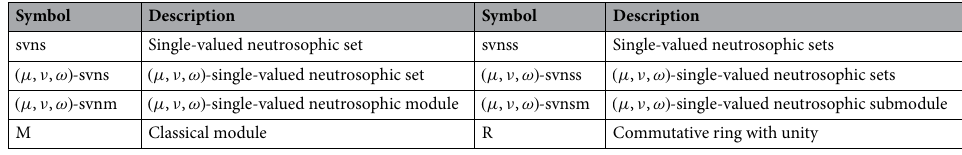
Table 1. Symbols and description of this